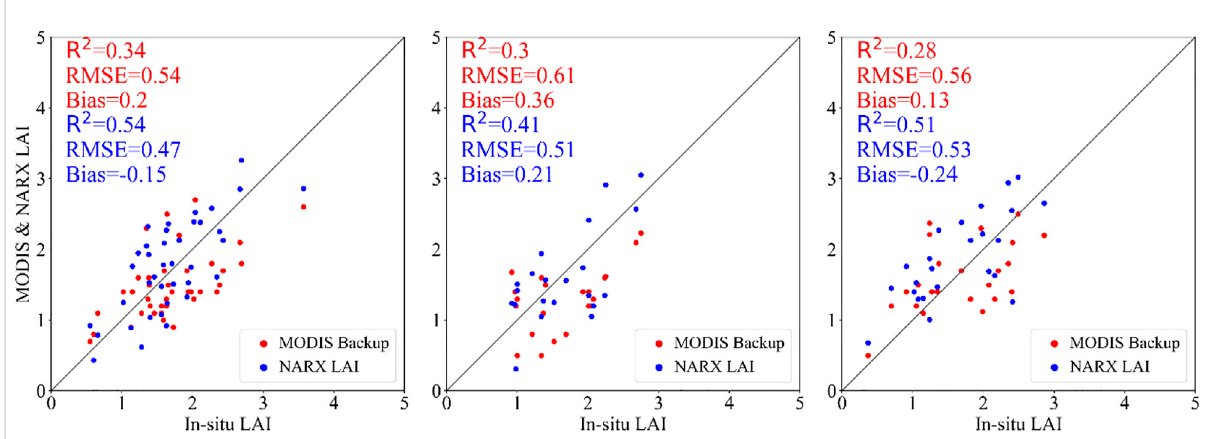
FIGURE 5 Comparison of the relationship between the in situ cropland LAI and NARXNN-improved LAI and the original MODIS backup algorithm- retrieved LAI (the red point represents a pair of in situ LAI and MODIS backup algorithm LAI, while the blue point represents a pair of in situ LAI and NARX LAI).